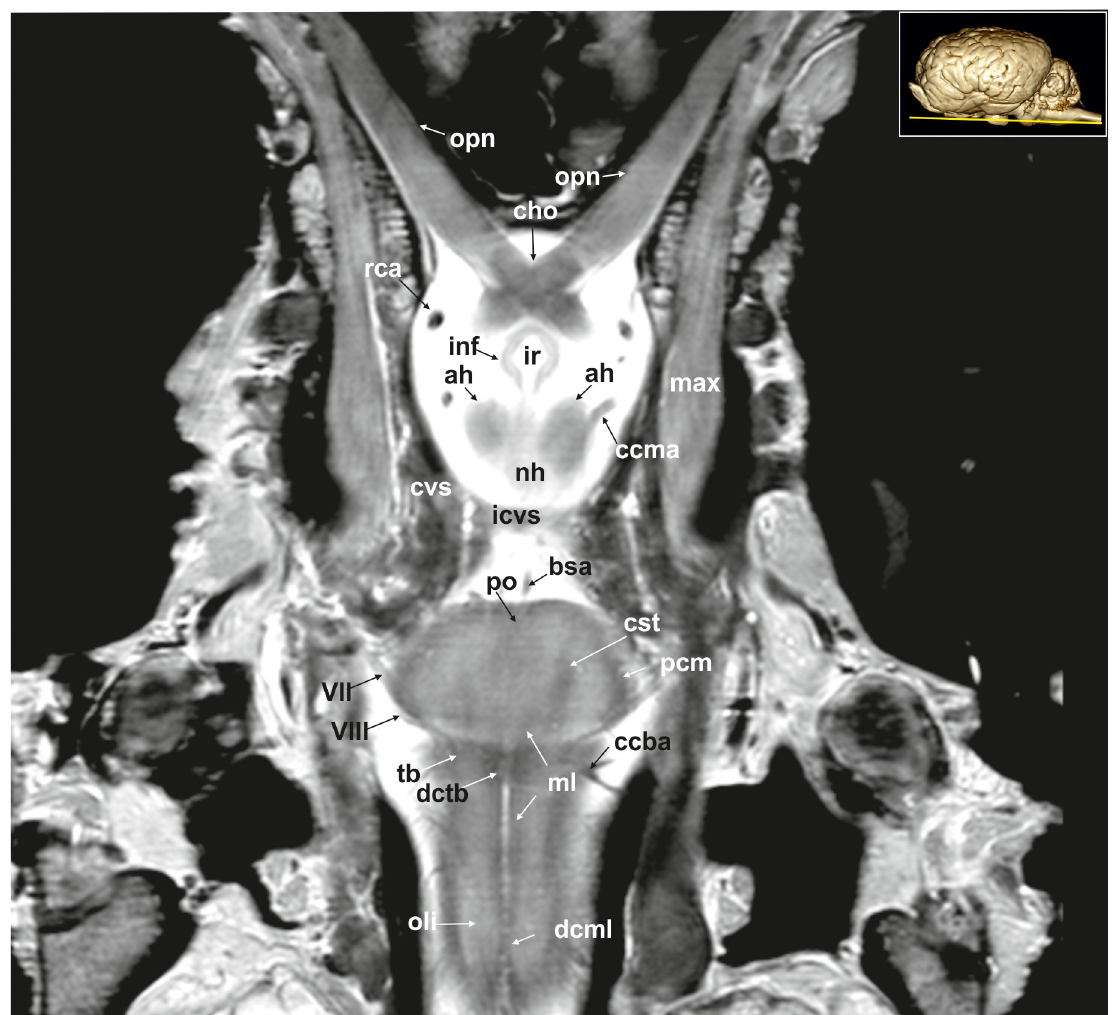
Fig 17. Dorsal magnetic resonance image of the equine brain on the level of the optic chiasm. ah: adenohypophysis, bsa: basilar artery, ccba: caudal cerebellar artery, ccma: caudal communicating artery, cho: optic chiasm, cst: corticospinal tract, cvs: cavernus sinus, dcml: decussation of medial lemniscus, dctb: decussation of the fibres of trapezoid body, icvs: intercavernous sinus, inf: infundibular stalk, ir: infundibular recess, max: maxillary nerve, ml: medial lemniscus, nh: neurohypophysis, oli: olivary nucleus, opn: optic nerve, pcm: peduncles of the mammillary body, po: pons, rca: rostral cerebral artery, tb: trapezoid body, VII: facial nerve, VIII: vestibulocochleal nerve.